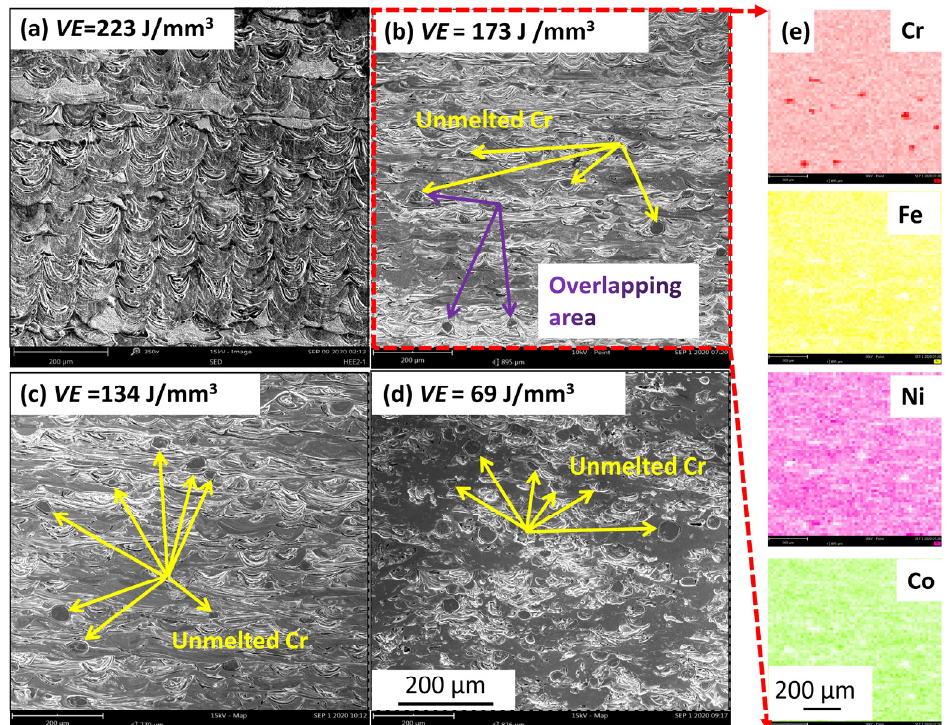
Figure 6. Microstructure and composition mapping on the XZ plane (parallel to the printing direction) of laser in situ alloying samples with a magnification of 350 × : ( a ) VE = 223 J/mm 3 , ( b ) VE = 173 J/mm 3 , ( c ) VE = 134 J/mm 3 , ( d ) VE = 69 J/mm 3 , and ( e ) energy spectrum scan results of region ( a ).